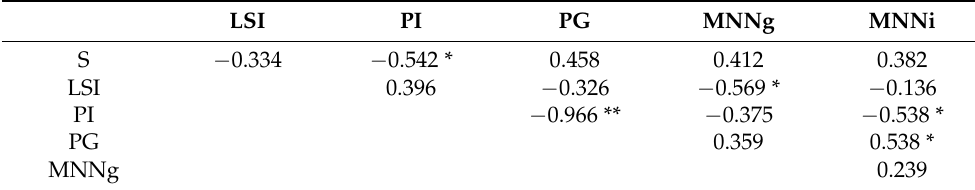
Table 6. Correlation analysis between selected impact factors.